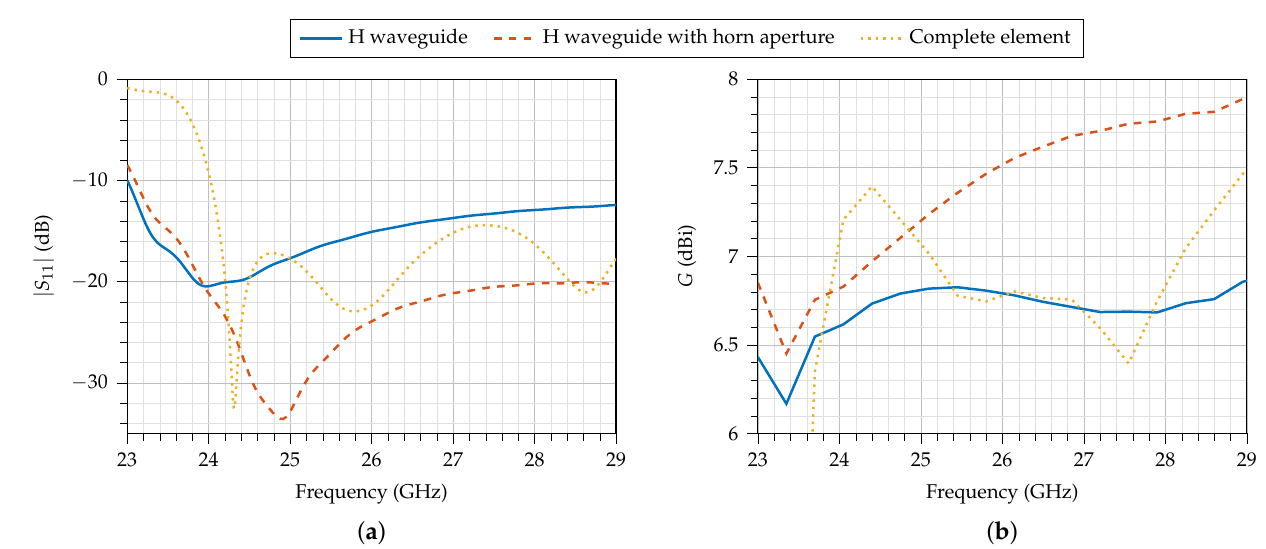
Figure 2. Properties of the design steps of element of antenna array: simulated ( a ) magnitude of S-parameter S 11 and ( b ) broadside gain G in the direction of x